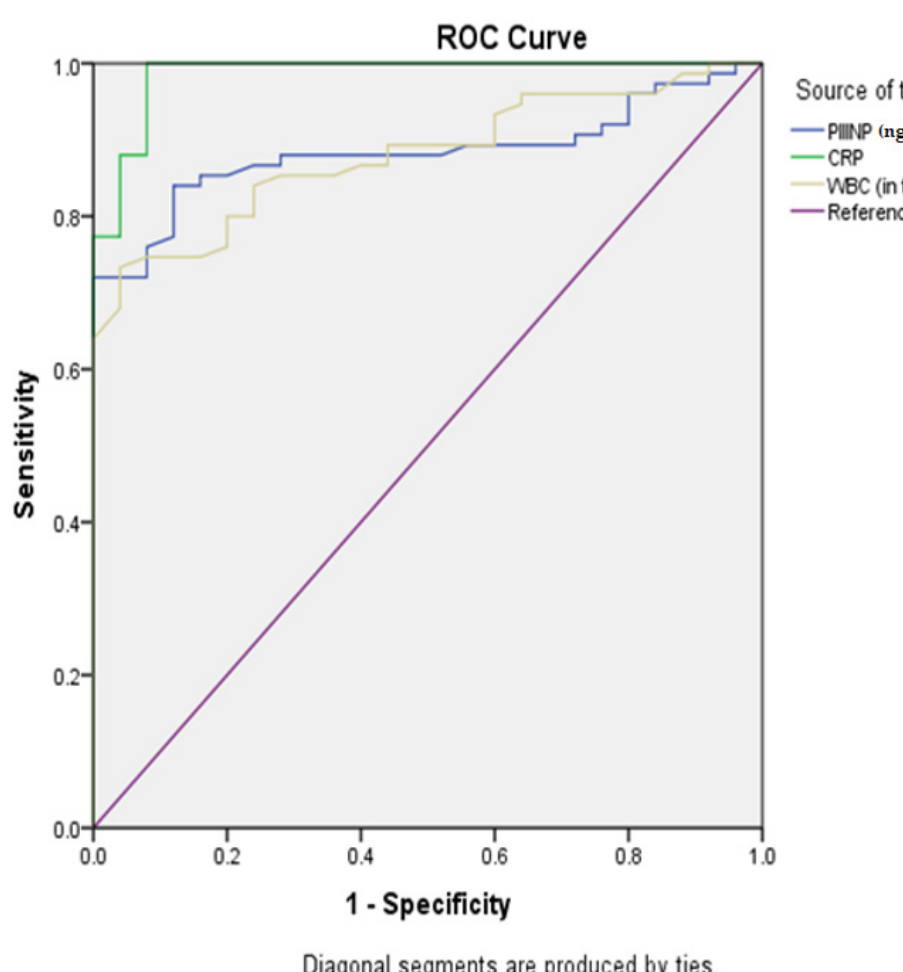
PIIINP = procollagen type III amino terminal propeptide; CRP = C-reactive protein; WBCs = white blood cells; AUC = area under curve; PPV = positive predictive value; NPV = negative predictive value. Regarding prognosis, the AUC curve for PIIINP to predict mortality was 0.651; the cut-off of 490.4 ng/mL had a sensitivity of 87.5% and specificity of 51.6% (Table 6 and Figure 2).